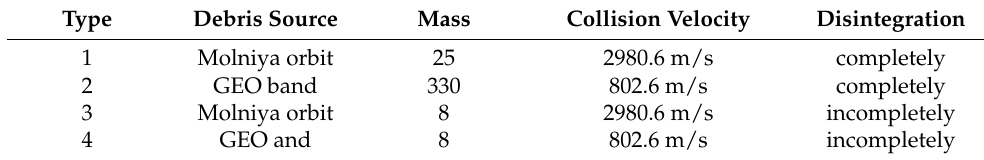
Table 1. Four types of